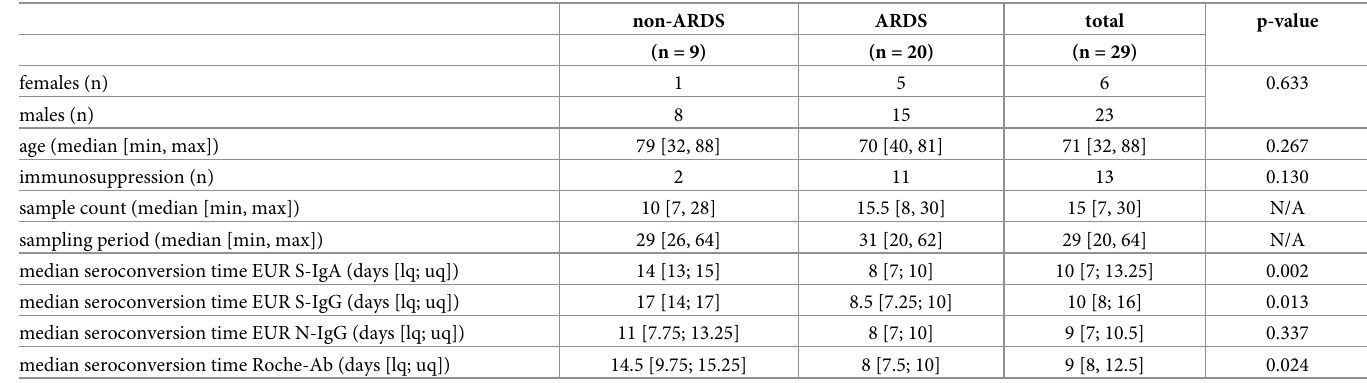
Table 1. Characterization of the PCR-positive clinical cohort and stratification into non-ARDS and ARDS patients with respective median seroconversion